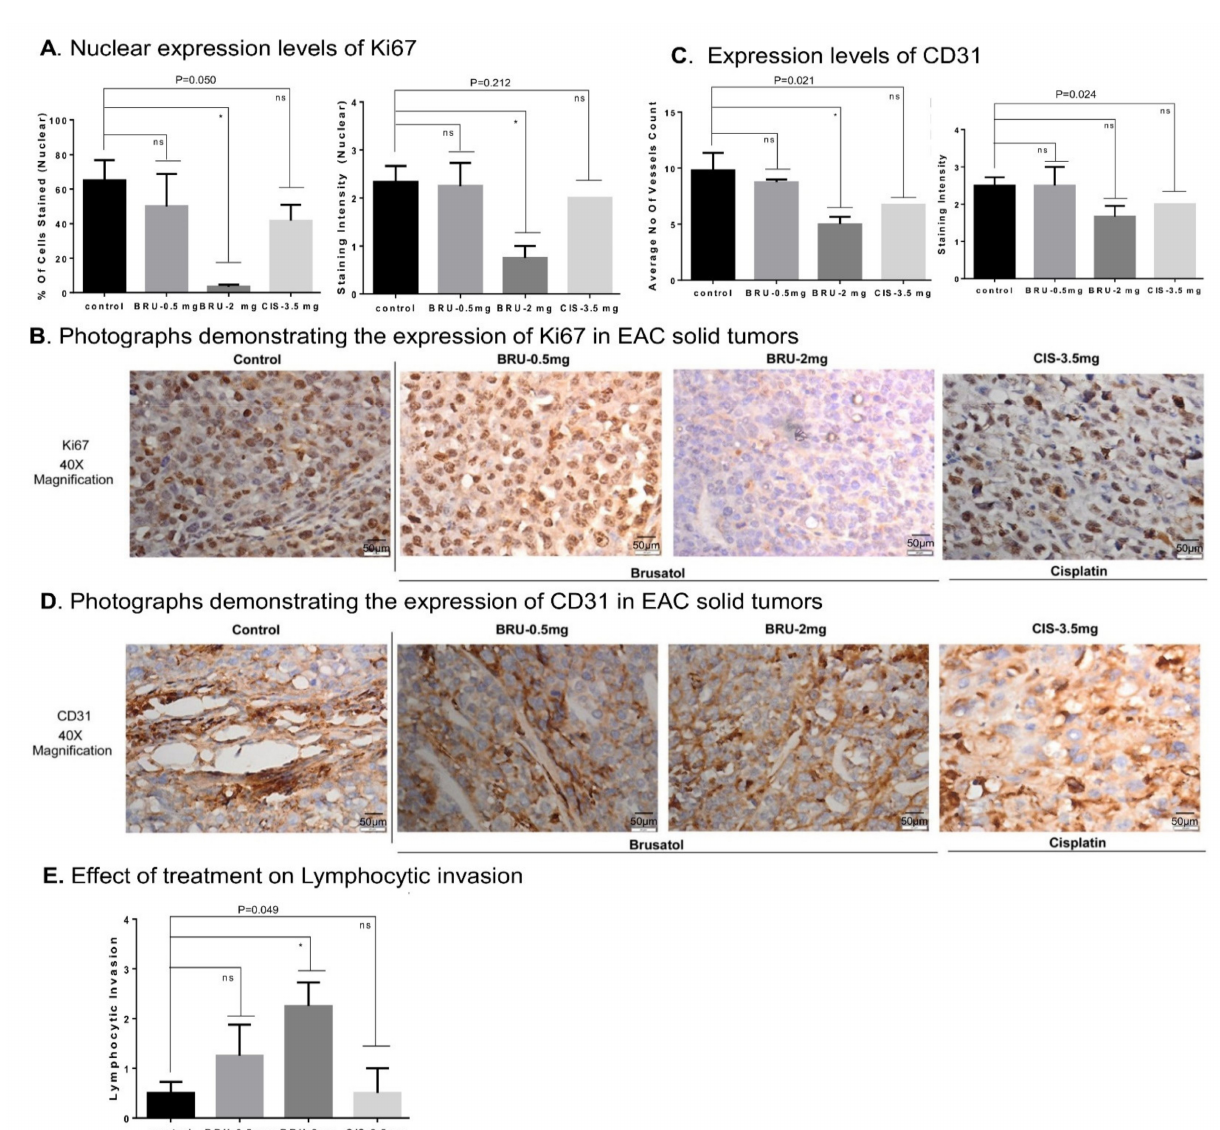
Figure 8. Brusatol reduced CD31 and Ki67 expression in grafted EAC tumor tissues and promoted lymphocytic